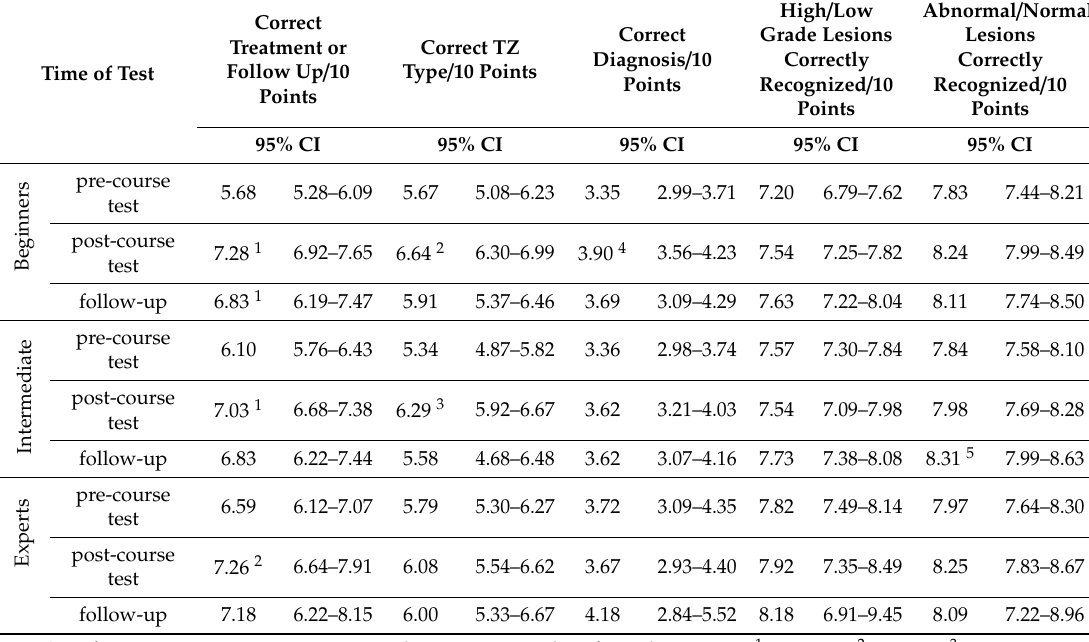
Table 2. Mean values and 95% confidence intervals (CI) for points in case questions and